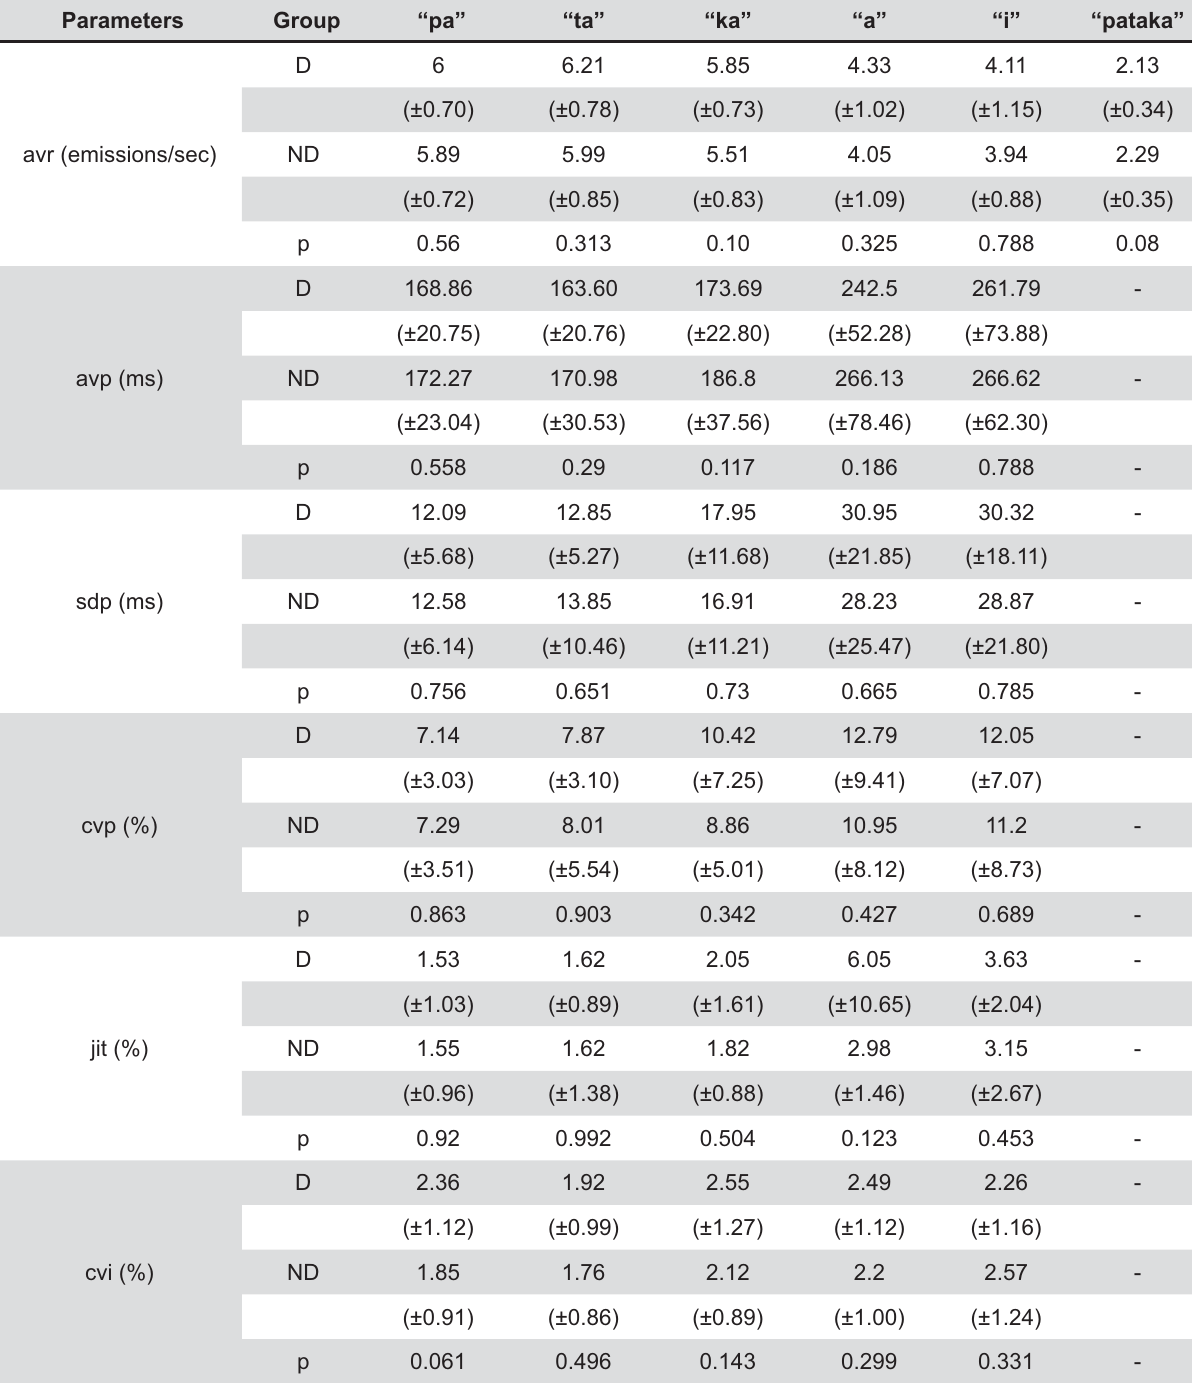
Table 1- Comparison of oral and vocal fold diadochokinesis (DDK) average and standard deviation, between dysphonic and nondysphonic women, in the emissions of “pa,” “ta,” “ka,” “pataka”, “a,” and